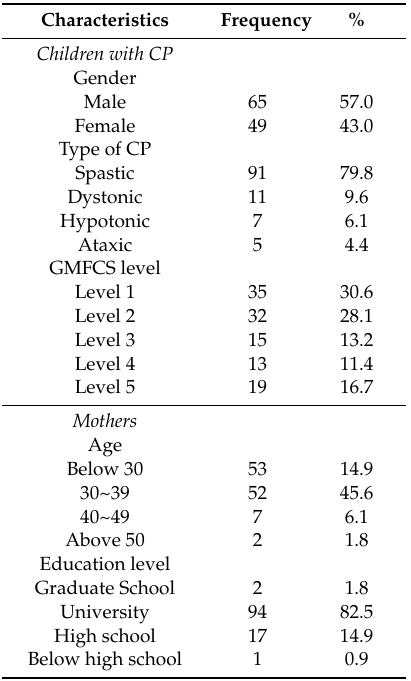
Table 2. Participants’ Characteristics (children with CP and their